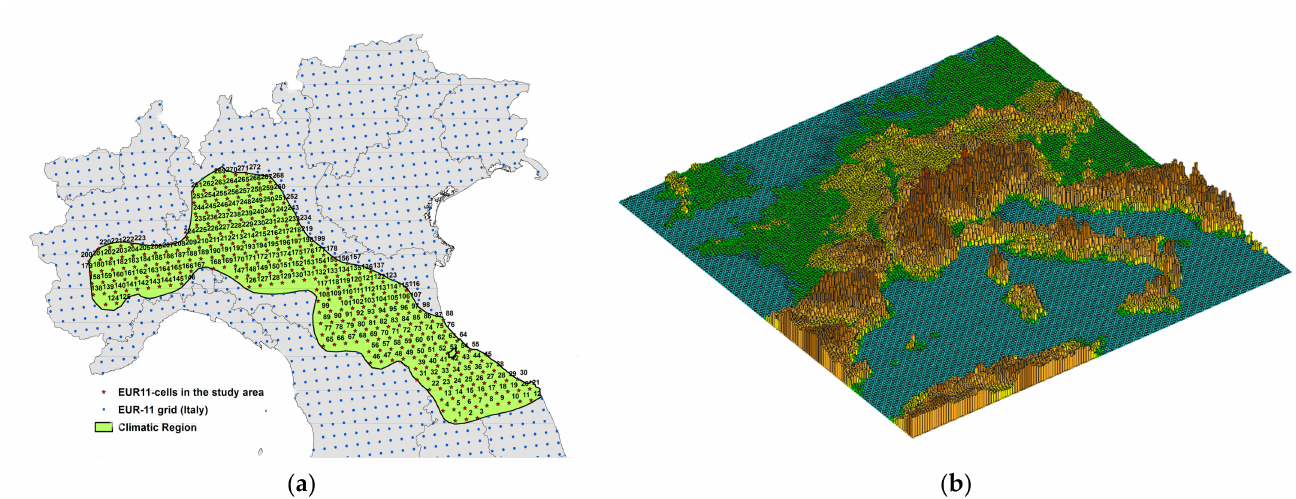
Figure 4. Investigated area in the Italian Mediterranean region ( a ), illustration of the Italian topography at EUR11-grid resolution ( b